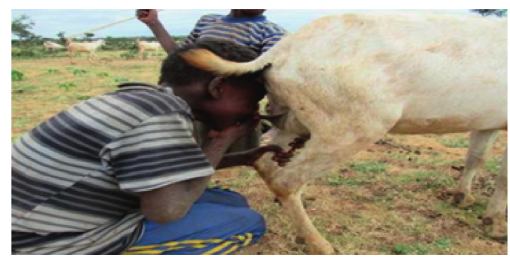
Figure 1: Risky milk consumption